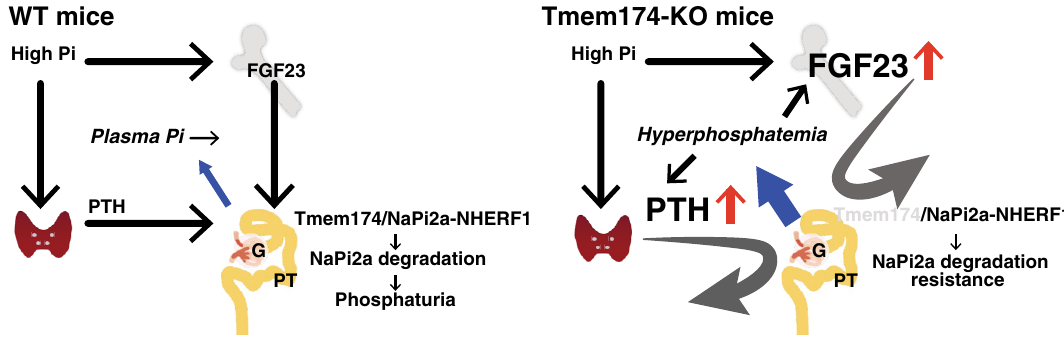
Figure 11. The putative role of Tmem174 in the control of plasma Pi levels. Tmem174 interacts with NaPi2a and is involved in internalization by PTH and FGF23. Under a high Pi load, urinary Pi excretion is enhanced by the internalization of NaPi2a induced by PTH and FGF23, and hyperphosphatemia is prevented. In Tmem174-KO mice, internalization of NaPi2a is resistant to PTH and FGF23. As a result, Pi reabsorption is maintained, and plasma Pi concentration increases. Tmem174 is expected to be a molecule that is associated with both the induction of phosphaturic hormones (PTH, FGF23) and the regulation of NaPi2a in the proximal tubules. G glomerulus, PT proximal